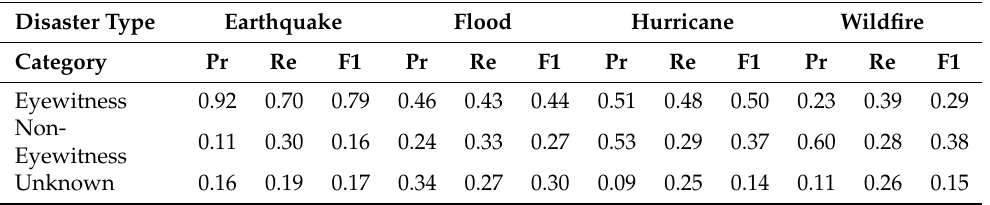
Table 8. Experiment-1: Manual Classification (F-Scores) 10-Features.